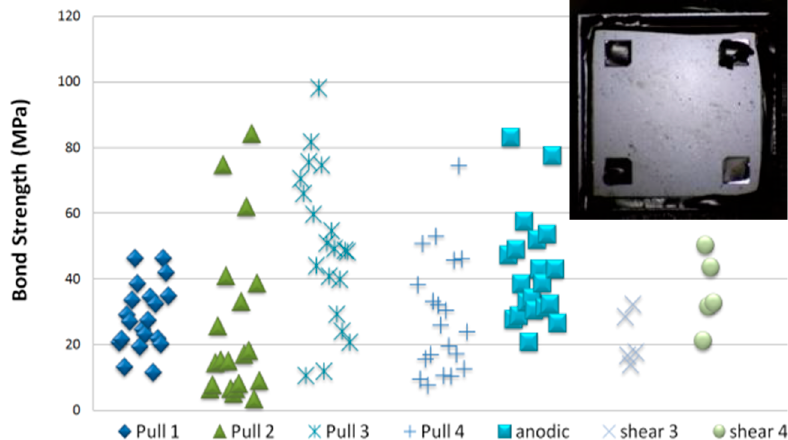
Figure 4. Cohesive fracture on silicon die and bond strength obtained with pull and shear